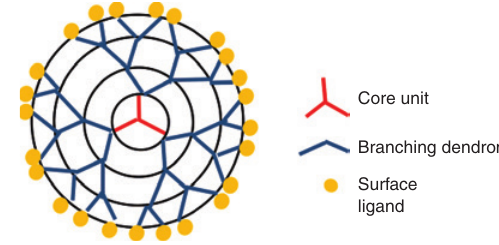
Figure 9: Schematic illustration of